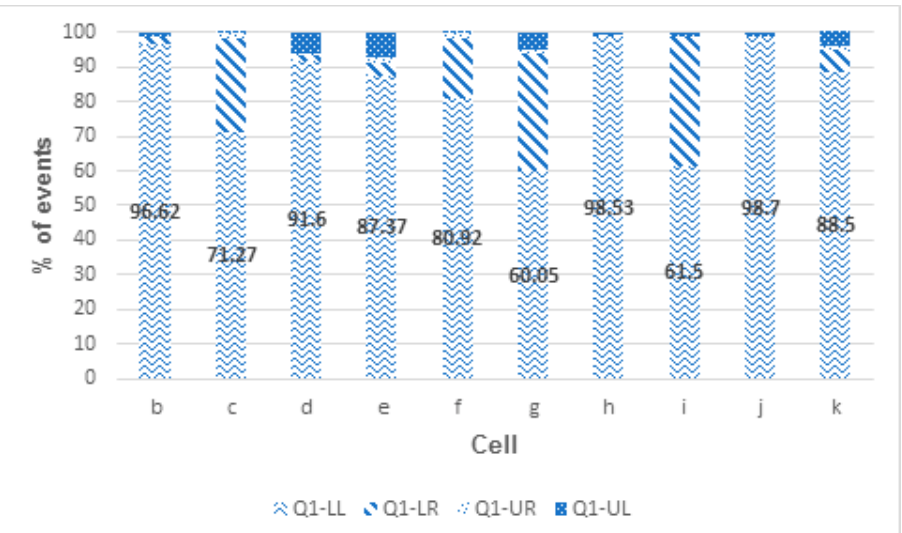
Figure 9. Percentage distribution of cells of selected fungal isolates showing changes in the structure of the cytoplasmic membrane. The diagrams take into account the percentage of cells in the cytograms’ quarters (Figure 8): (intact cells (Q1-LL), early apoptosis cells (Q1-LR), late apoptosis cells (Q1-UR), necrotic cells (Q1-UL)). ( b ) C. albicans from polyurethane foam. ( c ) C. subhashii from polyurethane foam. ( d ) C. albicans from Bialecki ring (25 × 25). ( e ) C. subhashii from Bialecki ring (25 × 25). ( f ) C. albicans from Pall ring. ( g ) C. subhashii from Pall ring. ( h ) C. albicans from Bialecki ring (50 × 50). ( i ) C. subhashii from Bialecki ring (50 × 50). ( j ) C. albicans —control with cells not immobilized. ( k ) C. subhashii —control with cells not immobilized.